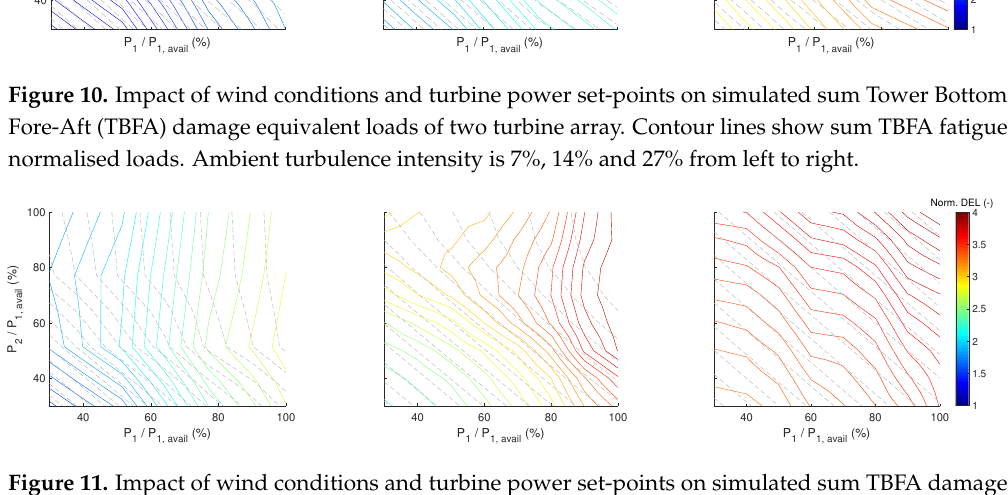
Figure 11. Impact of wind conditions and turbine power set-points on simulated sum TBFA damage equivalent loads of two turbine array. Contour lines show sum TBFA normalised fatigue loads. Ambient mean wind speed is 8, 12 and 16 m/s from left to